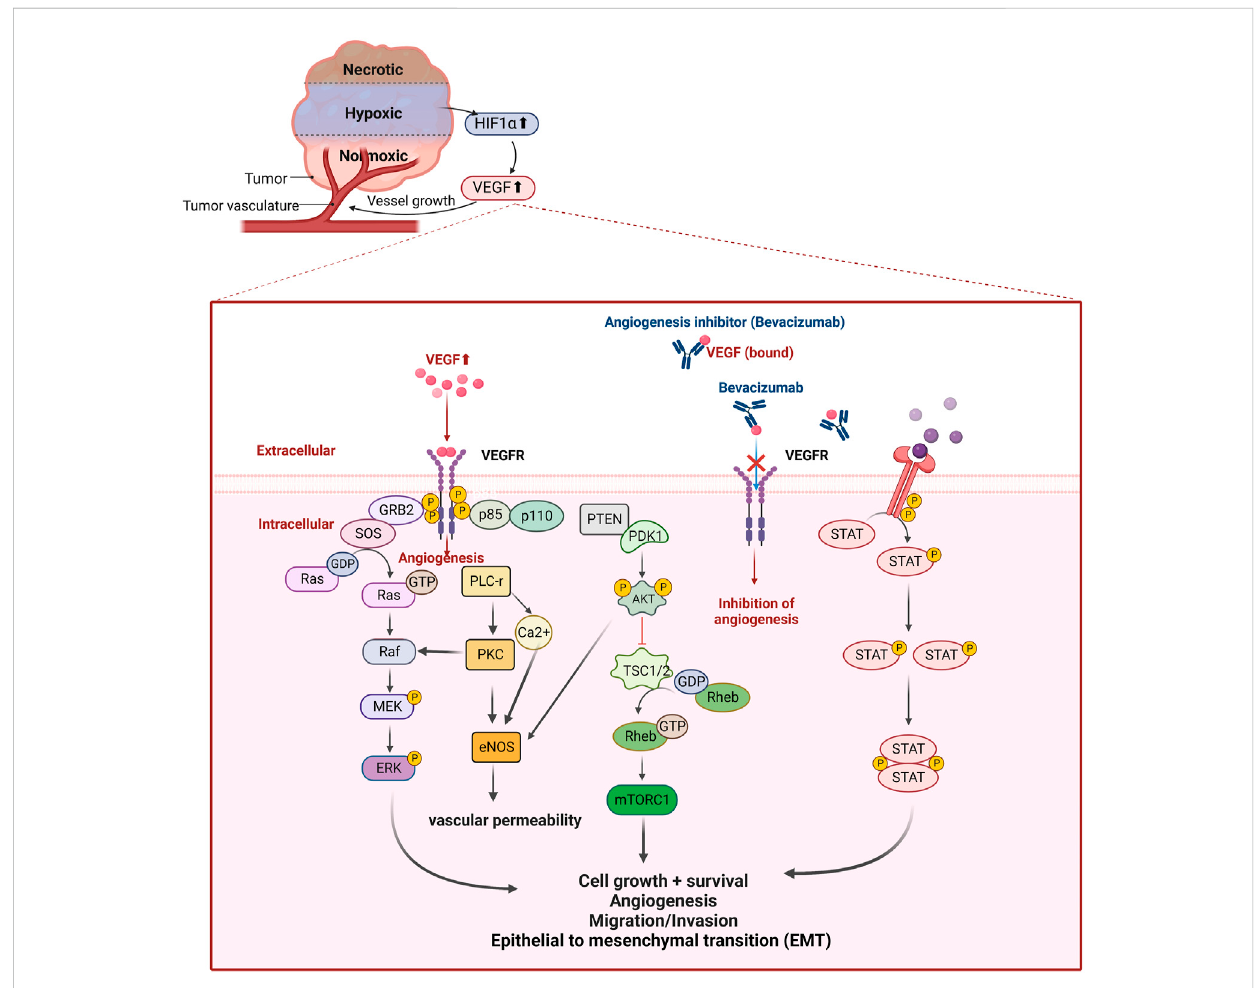
FIGURE 2 Hypoxicmicroenvironmentinovariancancerandtheprincipleofactionofangiogenesisinhibitors.Thehypoxicmicroenvironmentinsidethetumor mass induces increased HIF-1 α expressionand upregulates vascularendothelialgrowth factor (VEGF), whichregulates tumor angiogenesisby binding to its receptor and activates intracellular signaling pathways. Expression to promote EMT-induced angiogenesis mimicry; and activation of JAK-STAT signaling pathway to participate in angiogenesis. Bevacizumab, a recombinant humanized monoclonal antibody targeting VEGF, inhibits tumor neovascularization by speci fi cally binding to VEGF and preventing its binding to VEGFR, blocking the signaling pathway of